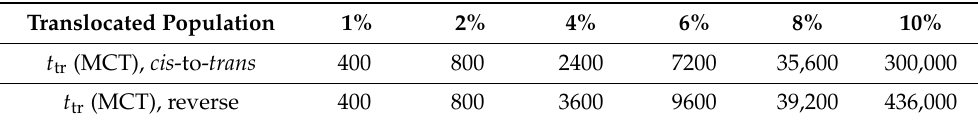
Table 2. Comparison of translocation times for the given populations of N = 20 engaging in the cis -to- trans and reverse directions. The time resolution is given by the binning size δ t = 400 MCT. Translocated